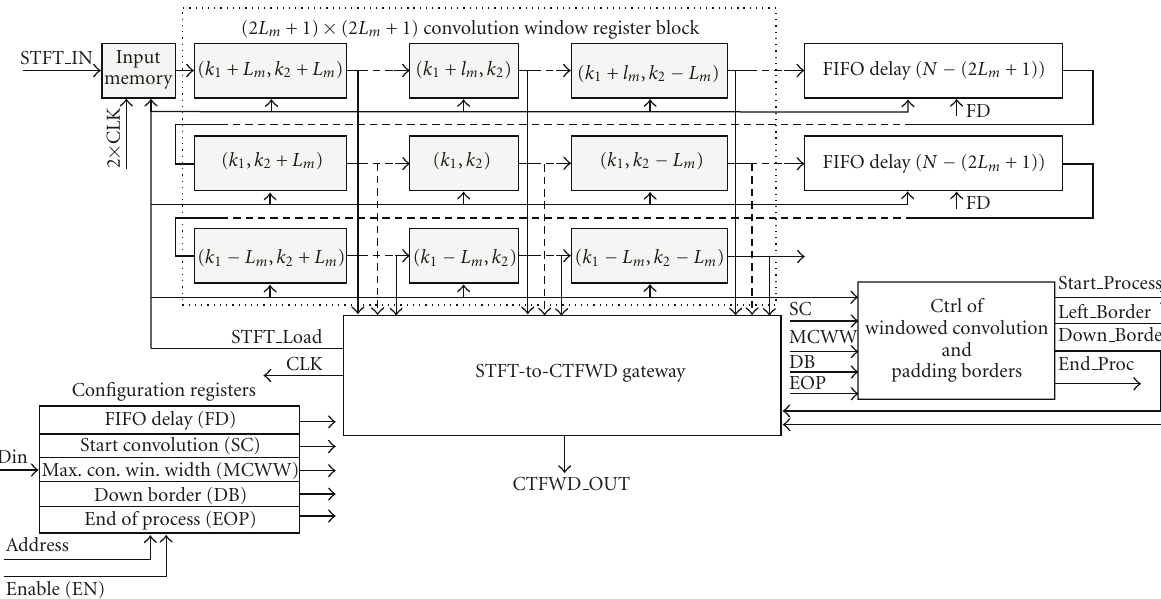
Figure 4: Proposed signal adaptive hardware design. In registers, the S/SF position of the stored 2D STFT element is denoted.